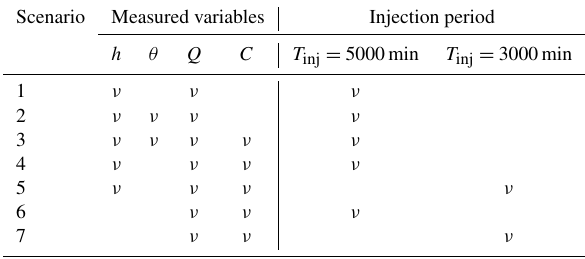
Table 2. Measurement sets and injection periods for the different scenarios. The pressure head h and the water content θ are measured at 5cm from the top of the column. The cumulative outflow Q and the concentration C are measured at the exit of the